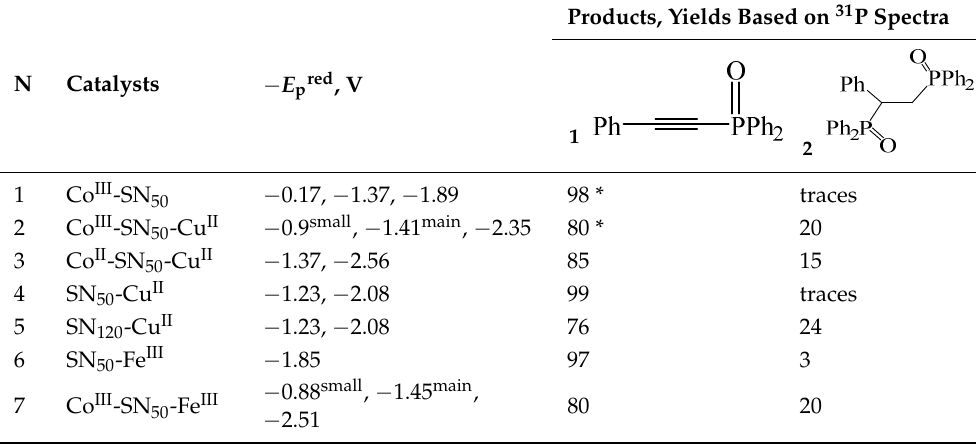
Table 2. Reduction peak potentials on nanoparticle-modified glassy carbon electrode. Products of Ph 2 P(O)H and phenylacetylene (1:1) coupling, 2F, CH 3 CN, Bu 4 NBF 4 .